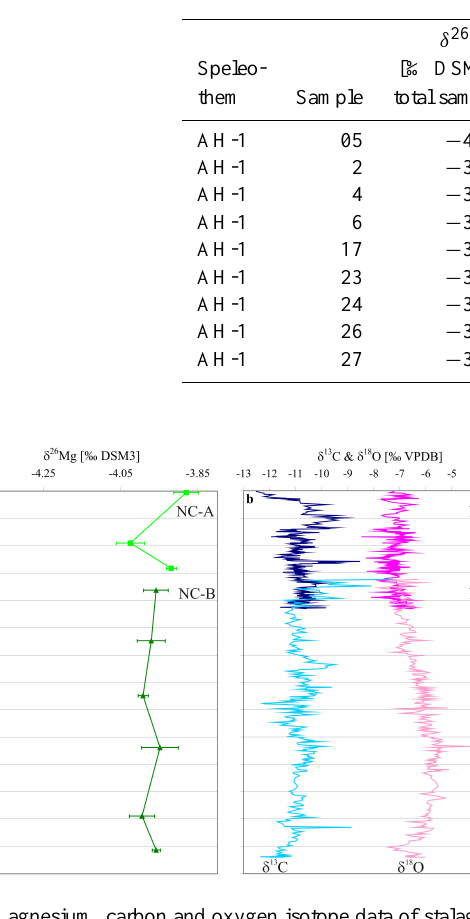
Fig. 7. Magnesium, carbon and oxygen isotope data of the stalag- mite GDA from Grotte d’Aoufous , Morocco. Black lines mark hia- tuses. (a) Mg-isotope data are plotted against distance from top in cm. Open triangles indicate multiple samples along a single growth layer (Buhl et al., 2007). (b) Carbon (dark blue) and oxygen (ma- genta) isotope data plotted against distance from top in cm (data from Buhl et al.,